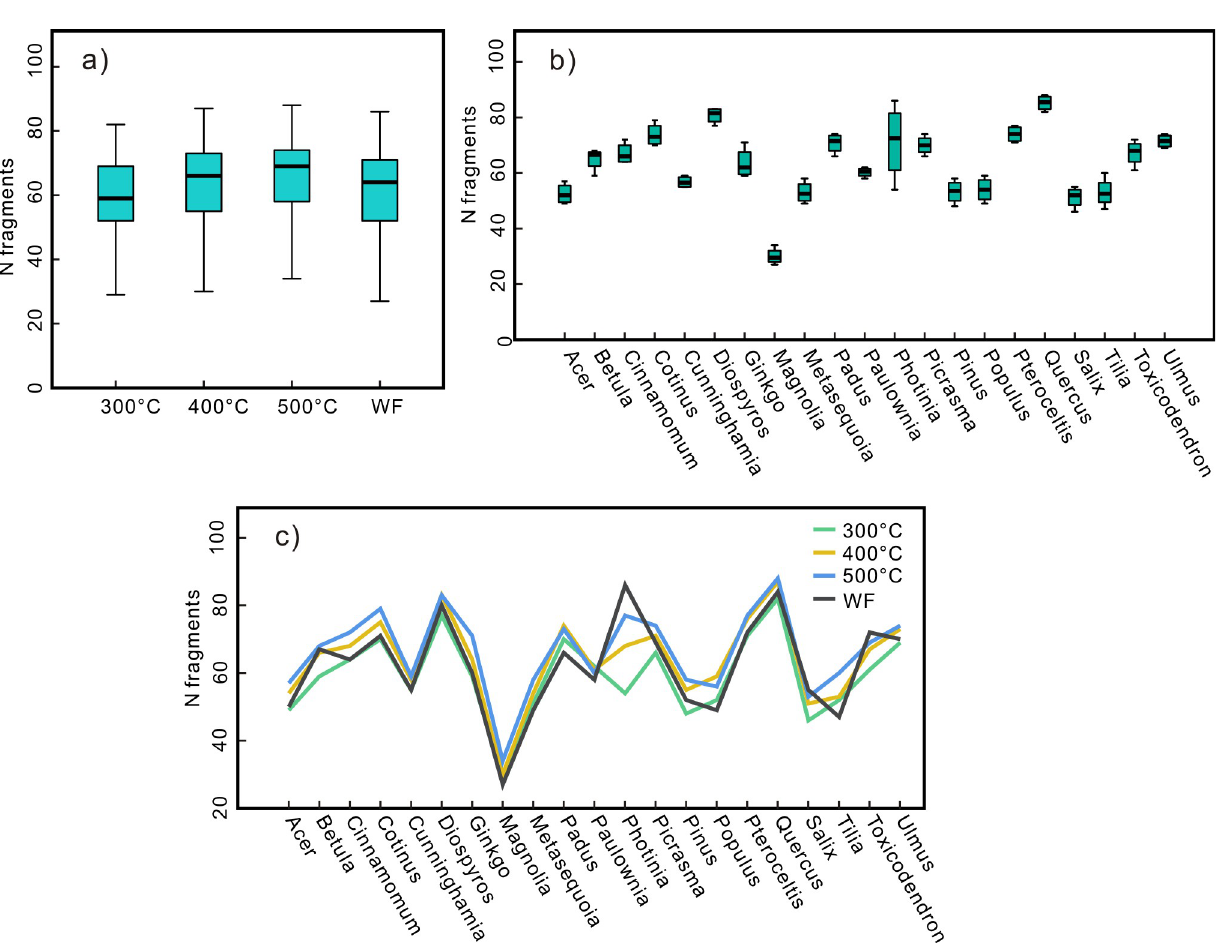
Fig 4. The number of charcoal fragments after the pressure experiment (a) at different temperatures; (b) different taxa (c) line chart of changes in the number of fragments at different temperatures.